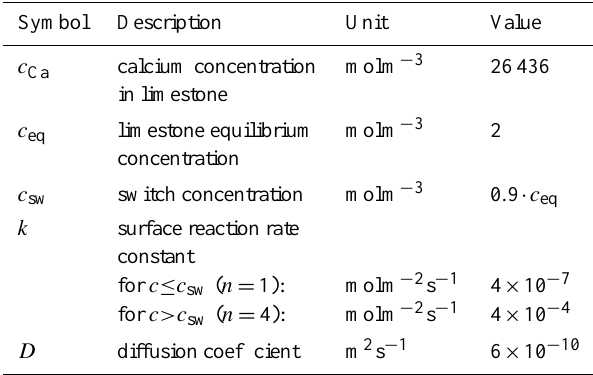
Table 1. Parameter values used for the